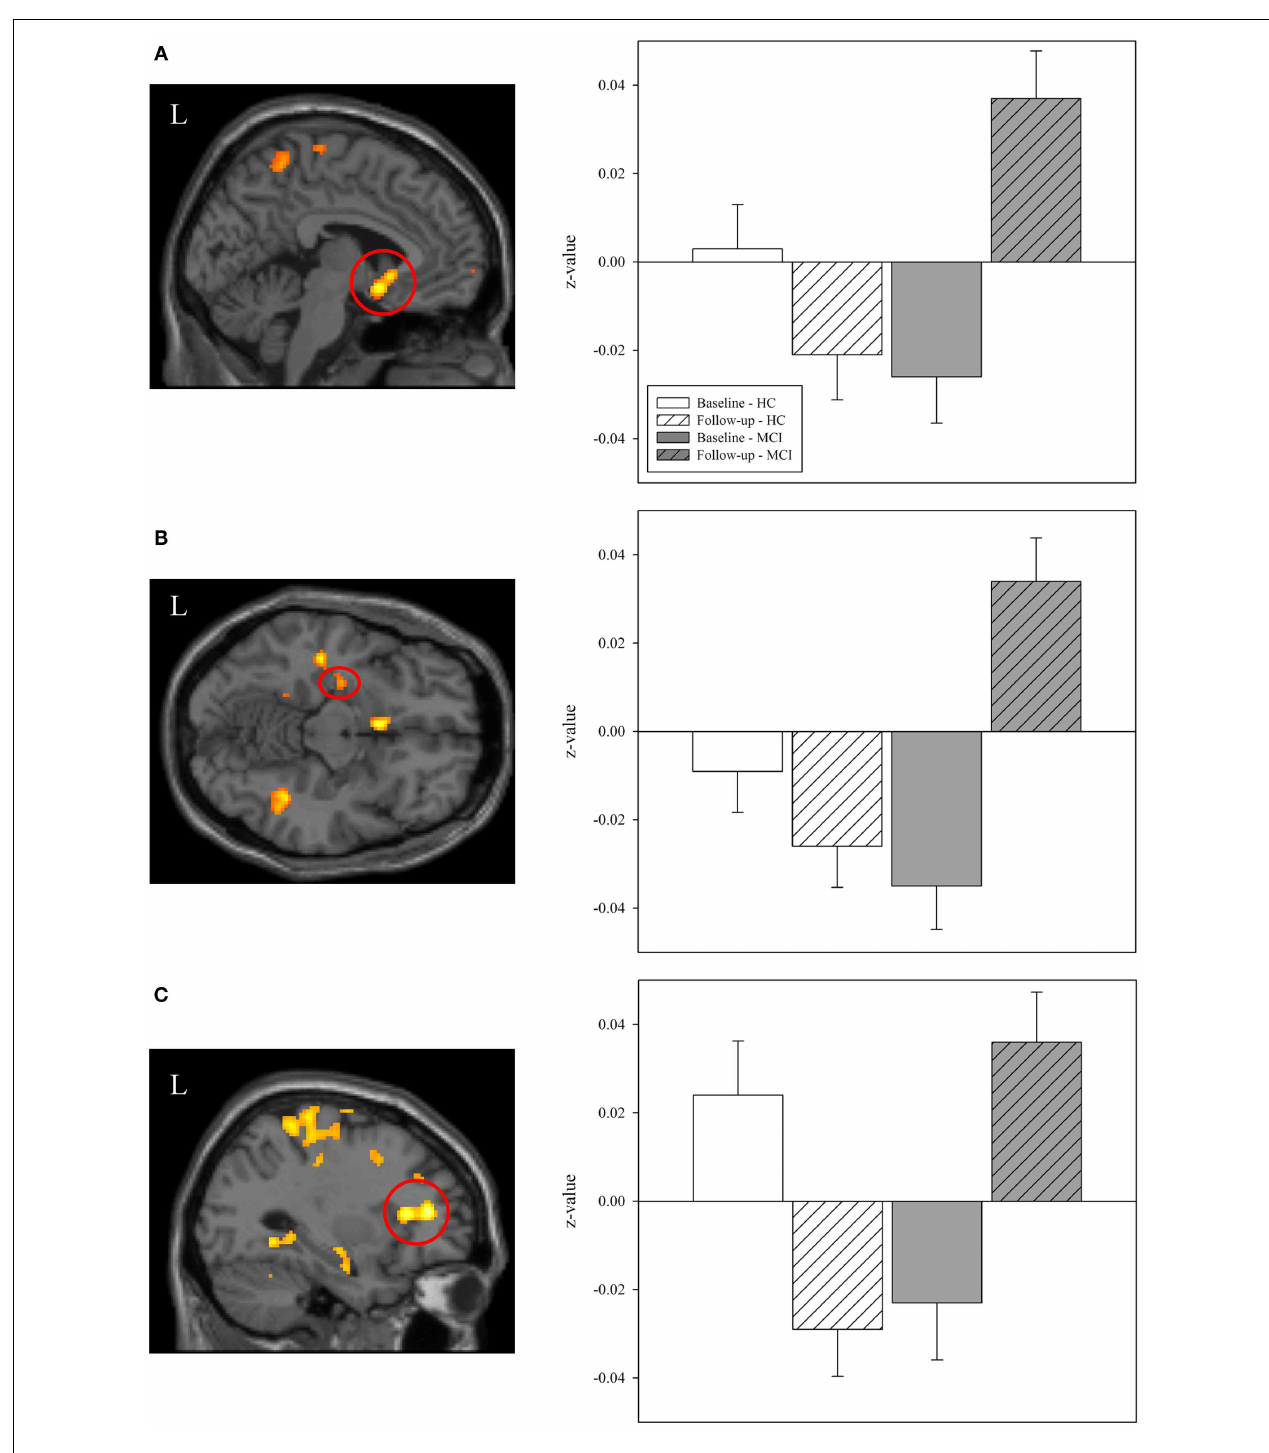
connectivity in the left frontal lobe (C) than MCI participants. However, at follow-up, MCI patients showed greater task-related functional connectivity than HC participants in all evaluated regions (A–C) . As expected, a significant interaction of diagnostic group-by-time was observed for each ROI (A–C) with MCI participants showing a greater increase in task-related functional connectivity between the baseline and post-treatment follow-up scans than HC participants ( p < 0.001). MCI = mild cognitive impairment, HC = healthy older adults, ROI = region of interest, R = right, L =